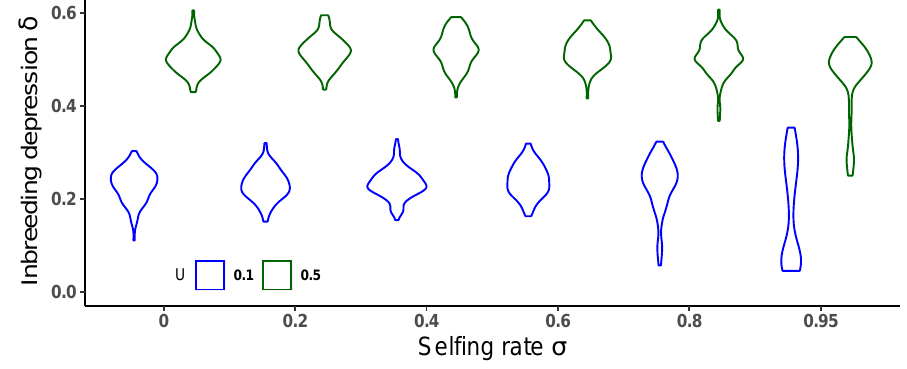
Figure S8 – Inbreeding depression in a population with a POD zone relative to one with- out as a function of the selfing rate σ at two genomic mutations rates, U , and two genomic map lengths, R . Other parameter values are n L = 100 and ℓ = 10 − tations randomly placed within the POD zone. Selection coefficients within and outside the POD zone, s and s d respectively are set to 0.01 , and dominances h and h d = 0.2 .